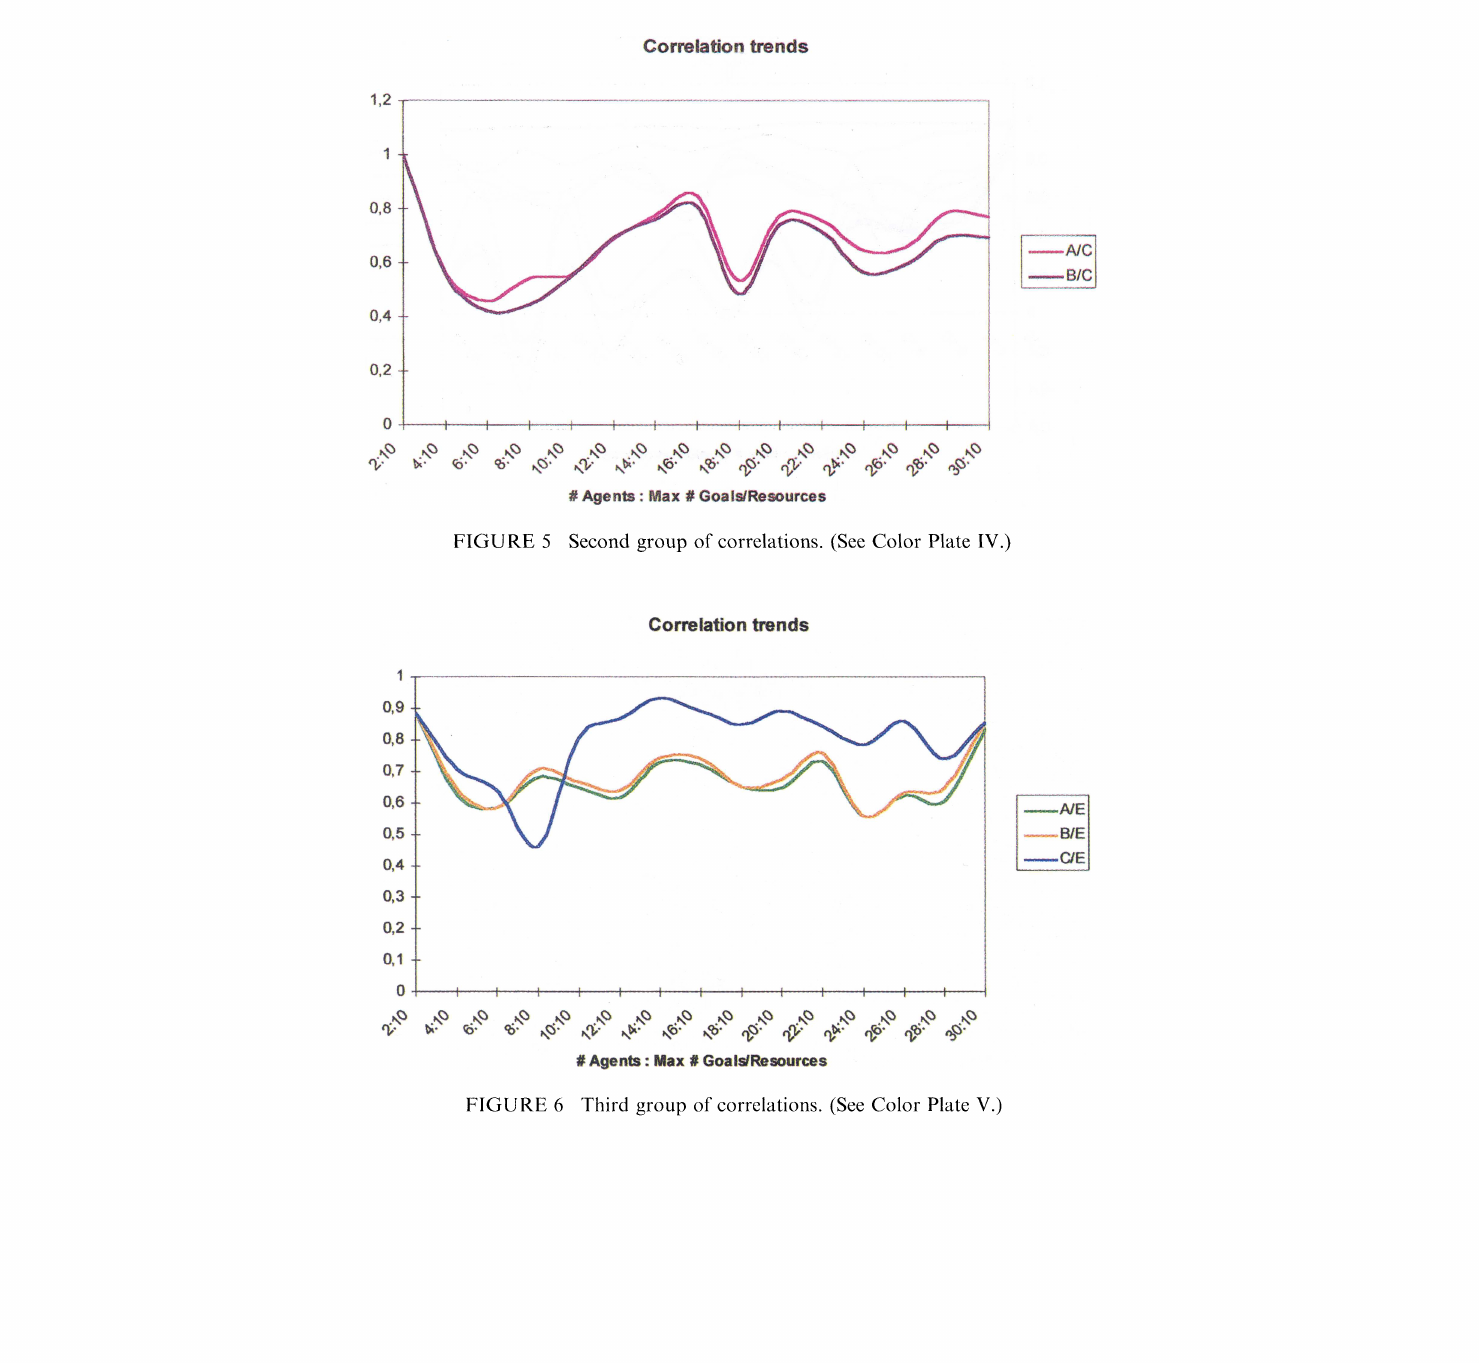
FIGURE 5 Second group of correlations. (See Color Plate IV.)